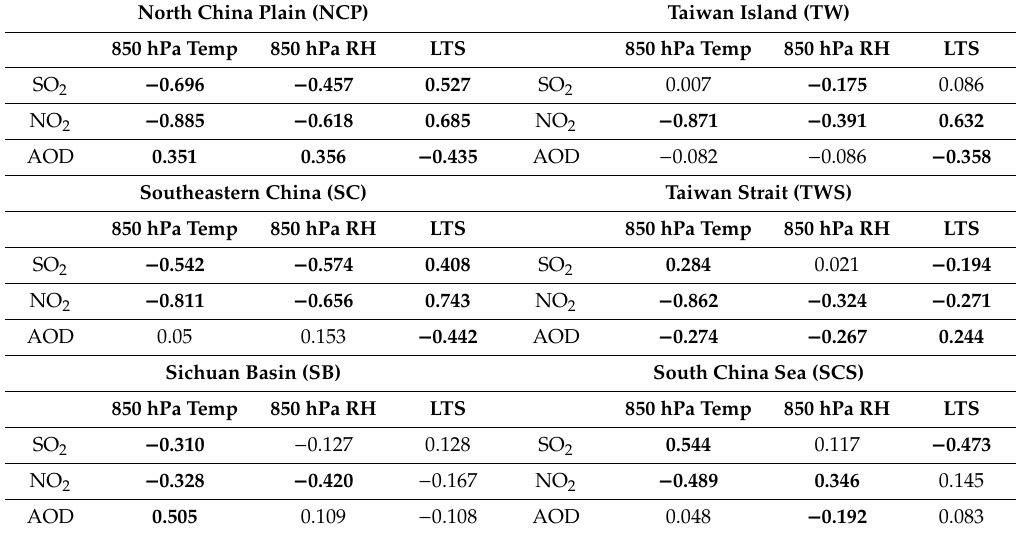
Table 1. Summary of correlation coe ffi cient of pollutants (sulfur dioxide (SO 2 ), nitrogen dioxide (NO 2 ), and aerosol optical depth (AOD)) to meteorological factors (850 hPa temperature, 850 hPa relative humidity (RH), and lower tropospheric stability (LTS)) for monitoring regions. Statistically significant ( p -value < 0.05) correlation coe ffi cient is marked with bold letters. North China Plain